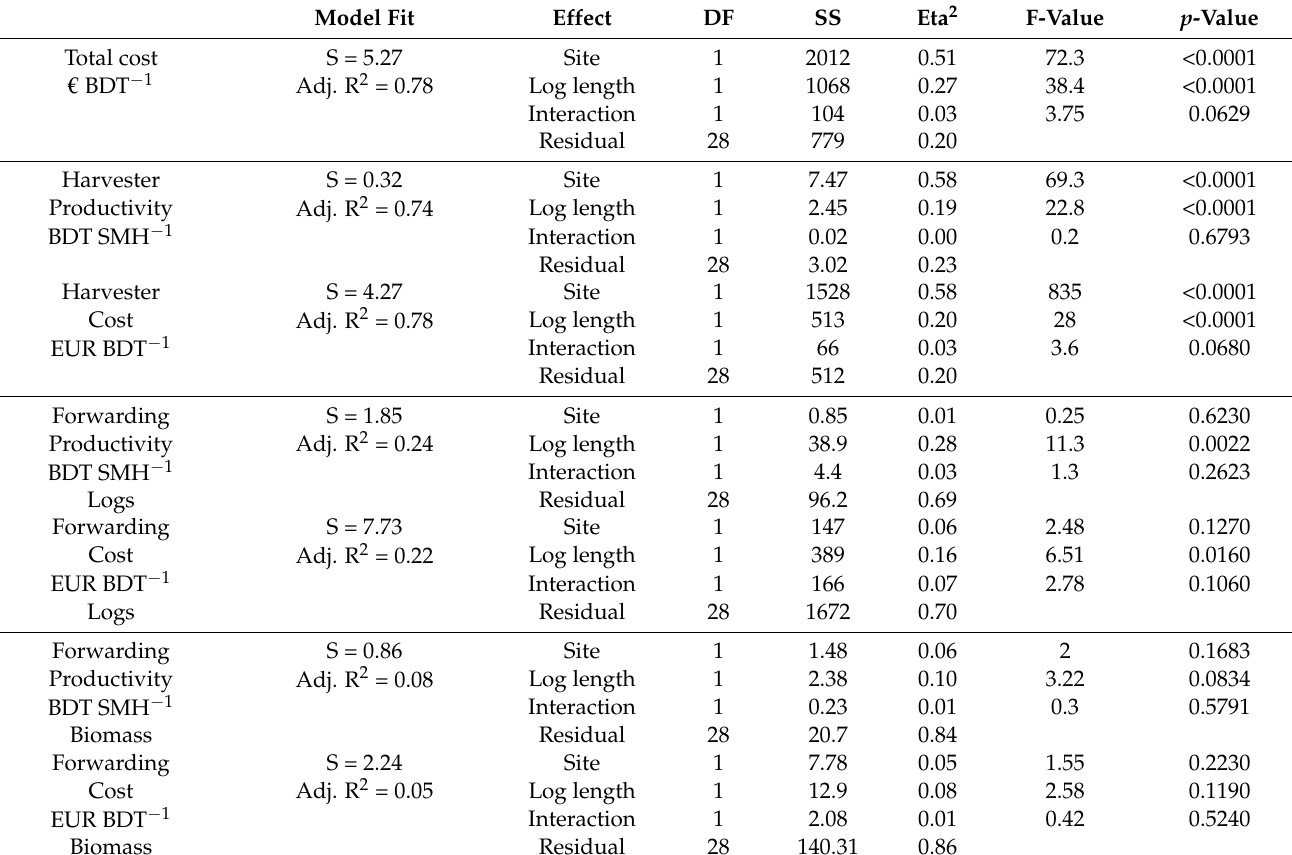
Table 3. Results of the ANOVA associated with the GLM.